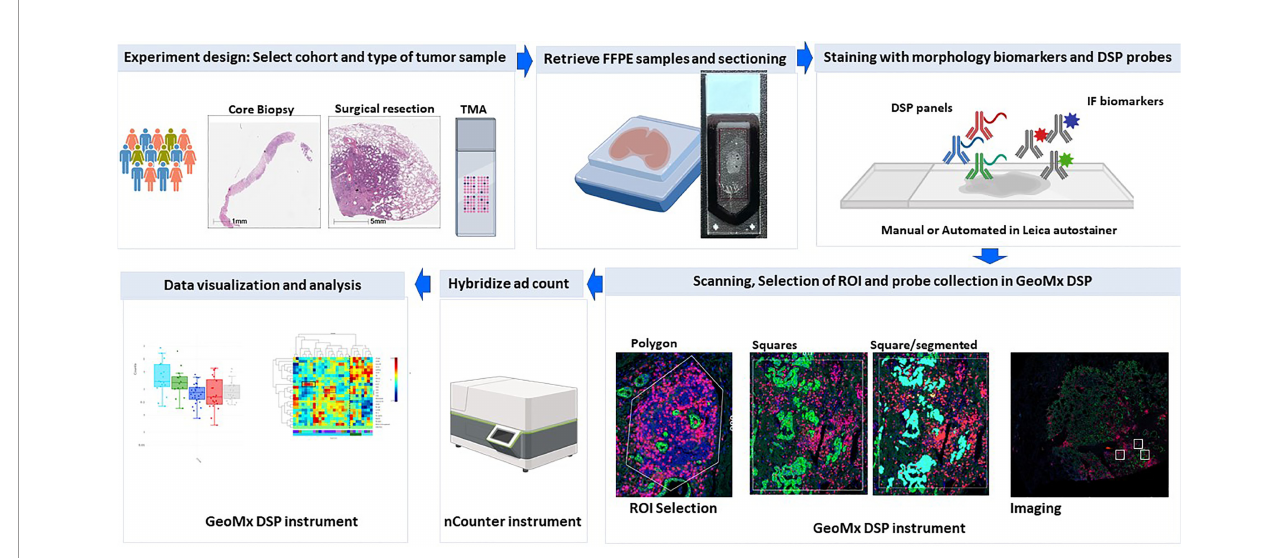
FIGURE 1 | DSP assay work fl ow. Schematic picture showing the work fl ow of pro fi ling using the Geomx